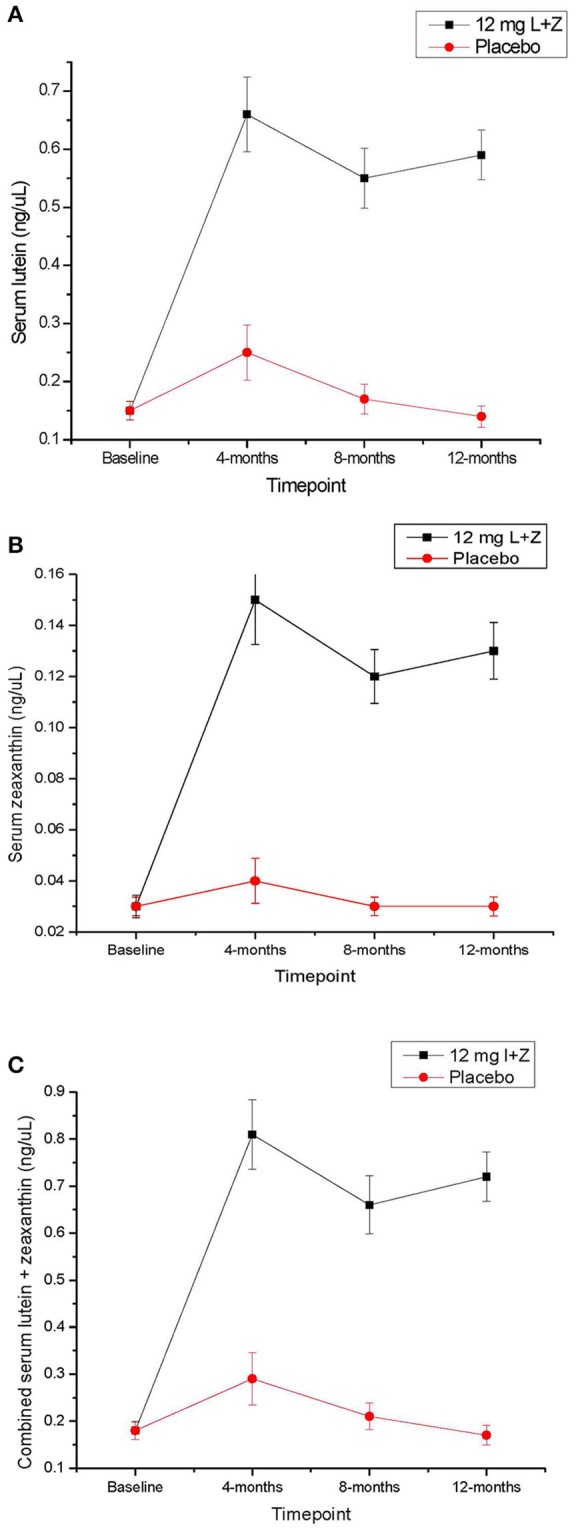
(A) Serum lutein across the 1-year intervention time period in participants taking the active study supplement, vs. placebo. Error bars represent the standard error of the mean. (B) Serum zeaxanthin across the 1-year intervention time period in participants taking the active study supplement, vs. placebo. Error bars represent the standard error of the mean. (C) Serum lutein + zeaxanthin levels across the 1-year intervention time period in participants taking the active study supplement, vs. placebo. Error bars represent the standard error of the mean.